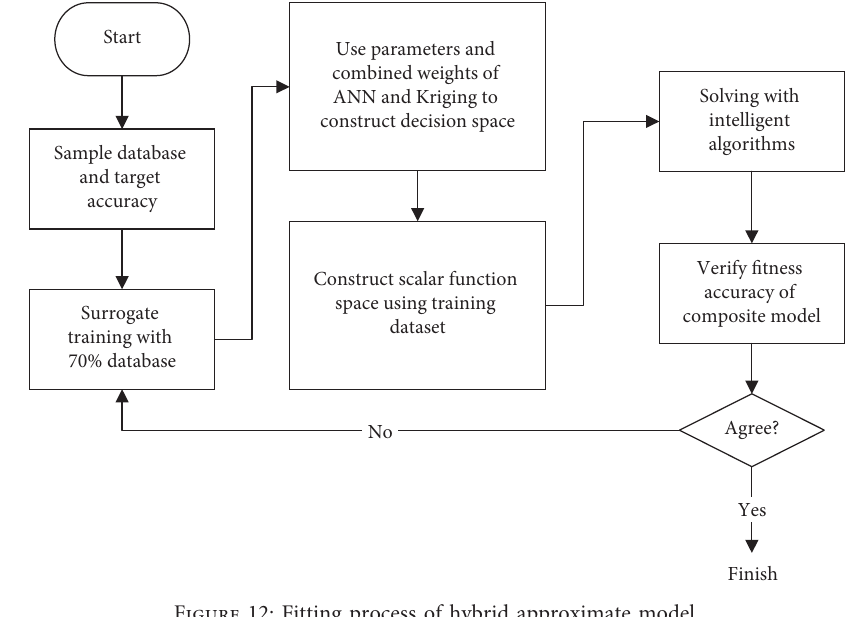
Figure 12: Fitting process of hybrid approximate